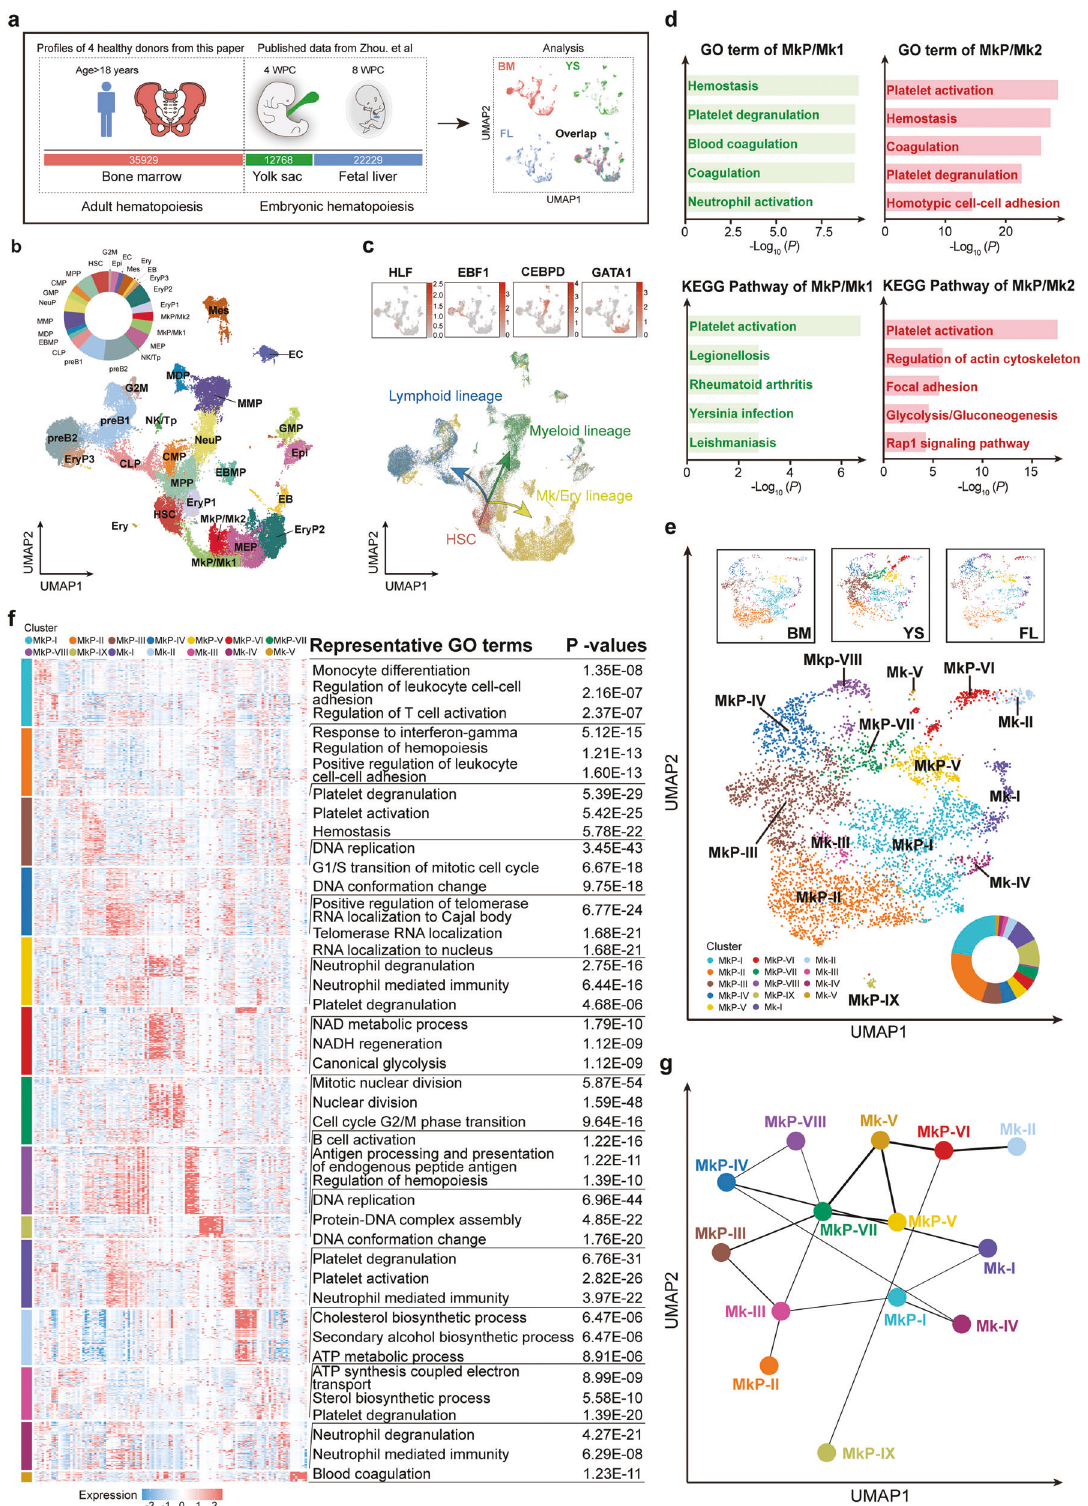
of gene sets in lists of genes ordered by population expression differences. Normalized enrichment score (NES), nominal P value, and false discovery rate (FDR) q value were used for the statistical analysis. The pathways with |NES|> 1, NOM p value < 0.05, and FDR q value <0.25 were considered to be meaningful.